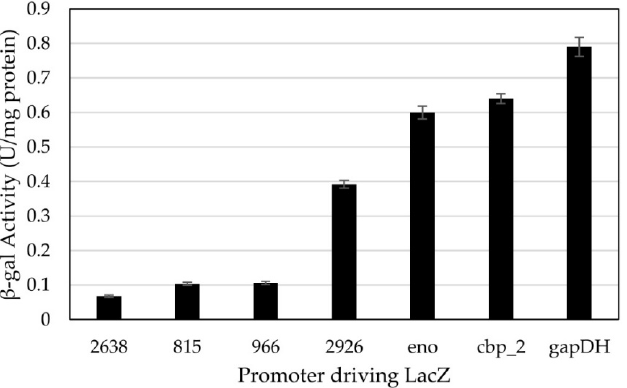
Figure 2. β -gal activities resulting from the expression of lacZ driven by different promoters in H. modesticaldum transformants. Units represent the nmoles of ONP formed per second of reaction. Data are represented as the average rate of three biological samples, with error bars representing the standard error.